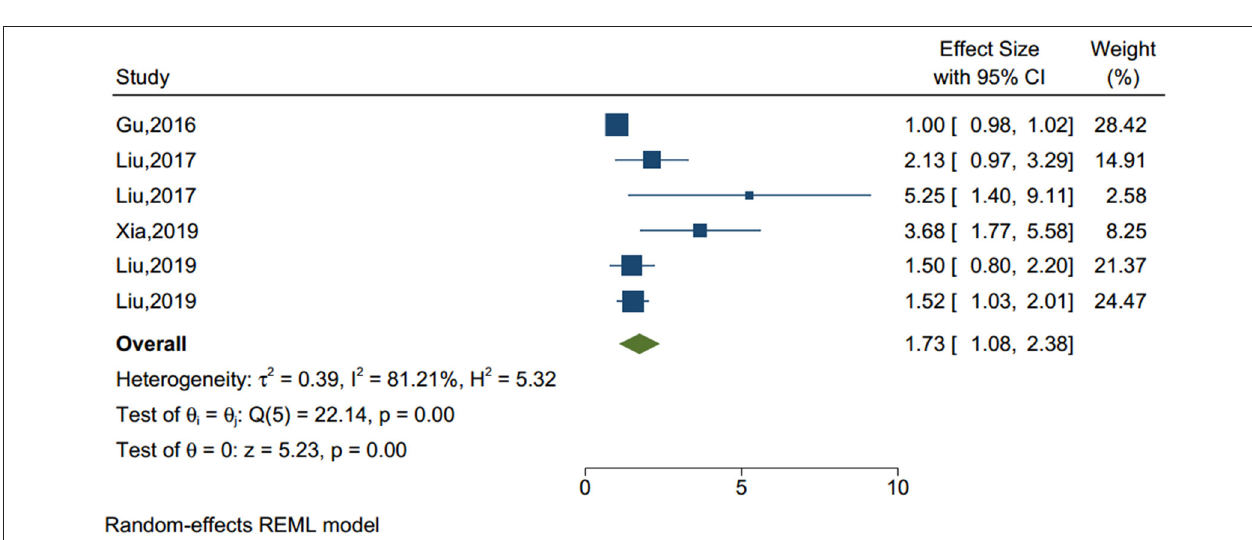
FIGURE 4 | Forest plot of studies including adverse life events factor.